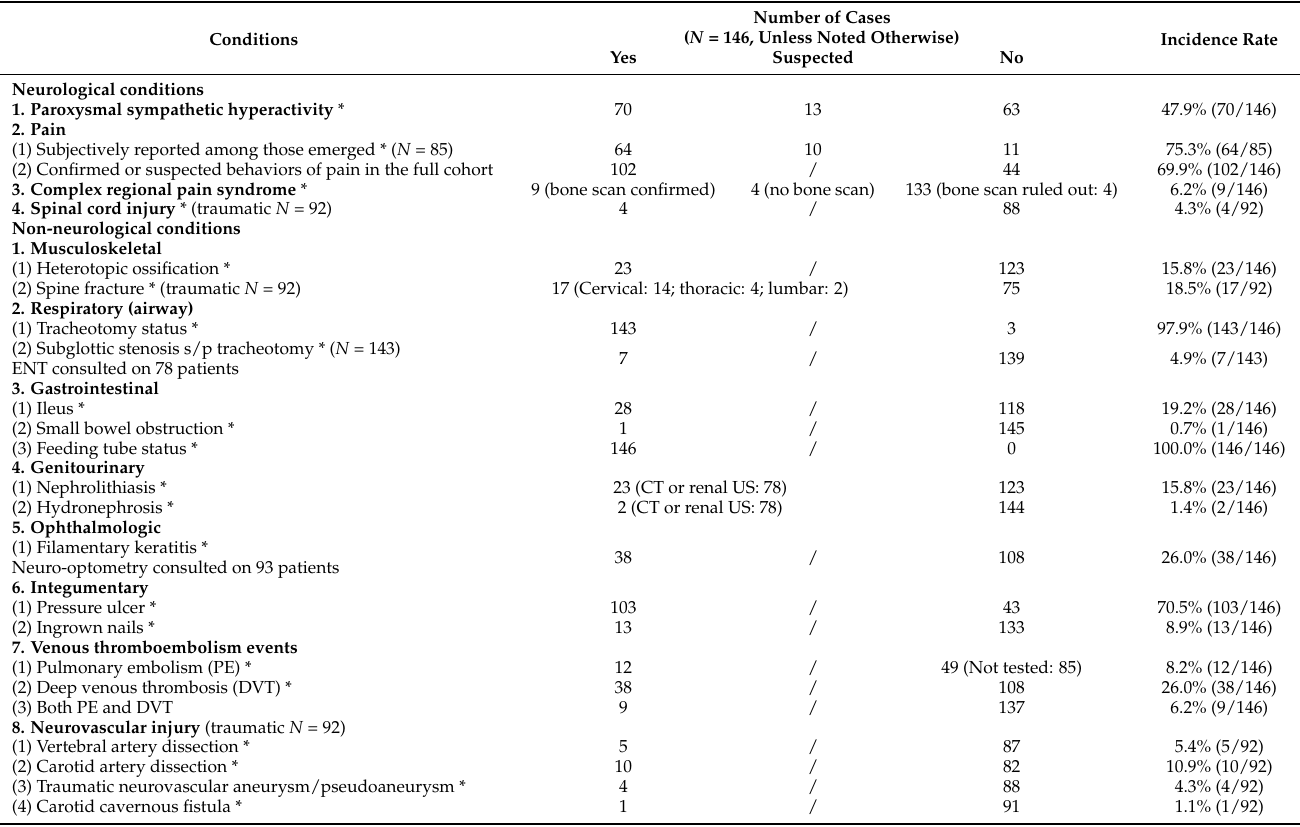
Table 4. Other common neurological and non-neurological complications and